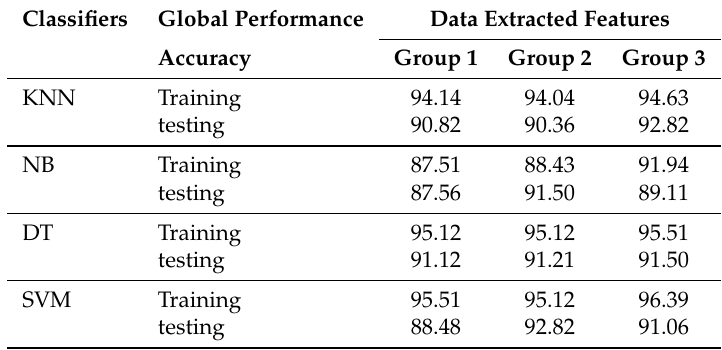
Table 3. Accuracies of extracted features based PCA with different